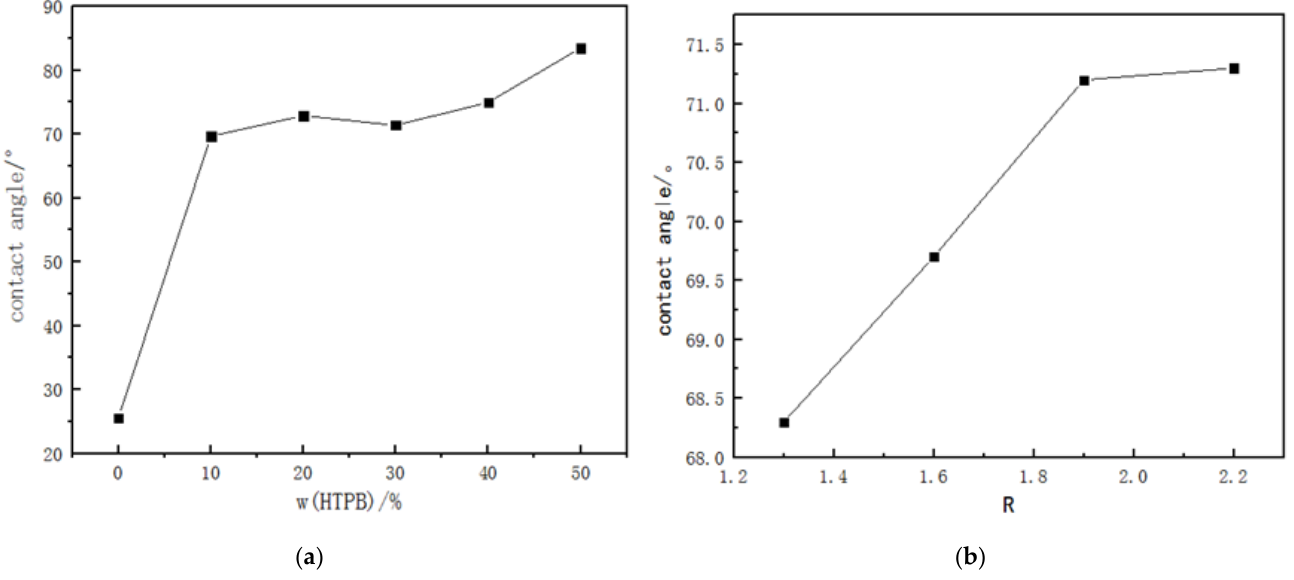
Figure 2. Contact angle results of HTPB-modified WPU: ( a ) Contact angle of WPU with different HTPB contents; ( b ) Contact angle of WPU with different R values.